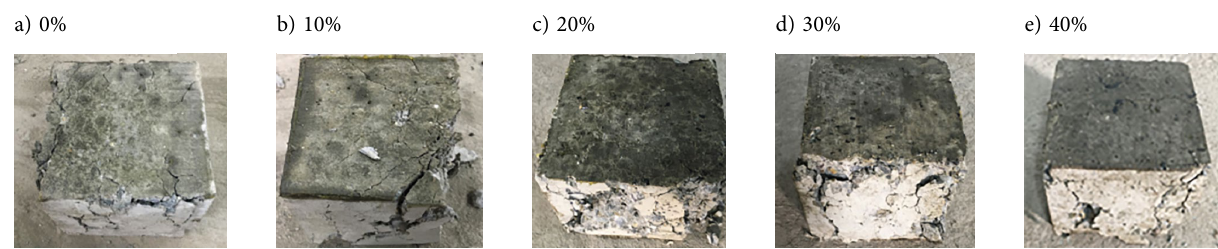
Figure 3. Compressive failure modes of rubber concrete with different substitution rates